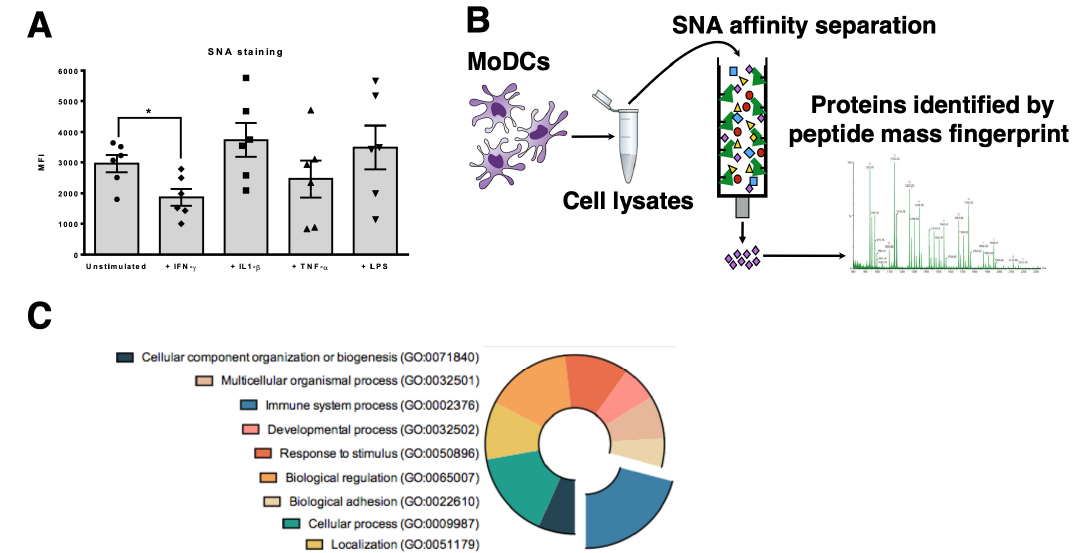
Figure 1. Mass spectrometry analysis of SNA-binding proteins isolated from DCs reveals key immune-related proteins. ( A ) The reactivity of Sambucus nigra (SNA) lectin to α 2,6-sialylated glycans on the surface of human DCs was quantified by flow cytometry after di ff erent maturation stimuli: IFN- γ , IL-1 β , TNF- α and LPS. Unstimulated DCs were used as control. Values presented are mean ± SEM (N = 6). Statistically significant di ff erences are indicated by asterisks (* p ≤ 0.05). ( B ) Schematic representation of the steps followed to identify α 2,6-sialylated proteins from DCs. Whole cell lysates of human DCs were immunoprecipitated through a SNA-binding column. The eluted proteins were analyzed by mass spectrometry and the corresponding identified scores were matched and associated with Gene Ontology (GO) entries. ( C ) Distribution of the identified sialylated proteins by their molecular function. Pie chart represents di ff erent molecular functions of the identified proteins, according to the GO entries. Immune system processes were